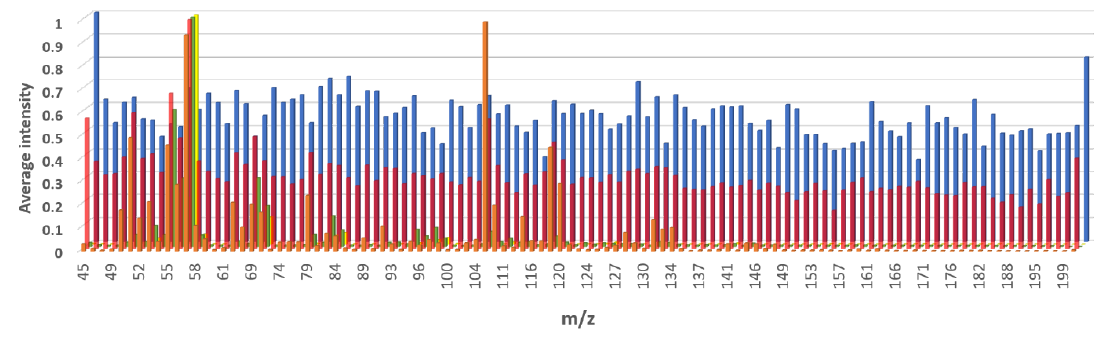
Figure 4. Average intensities of the m / z of the classification function coefficients.